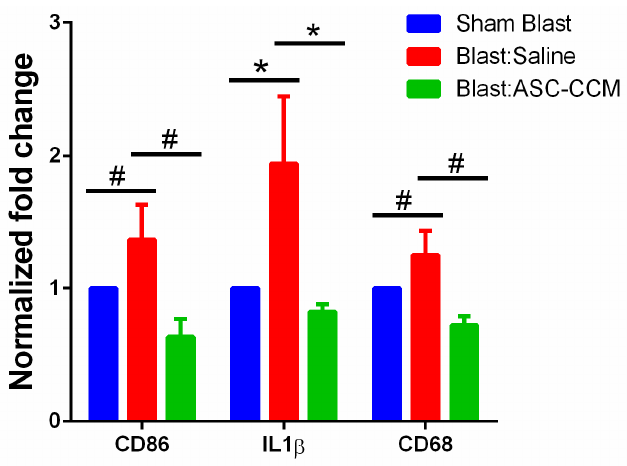
Figure 6. ASC-CCM reduces retinal inflammation in blast injury mice. ASC-CCM reduces retinal inflammation in blast injury mice. Assessment of gene expression by TaqMan qPCR and expressed as fold change normalized to internal control (18s rRNA) in the study groups. Data represent Mean ± SEM from n = 3–4 animals/group performed in duplicates repeated two additional times with similar data. #, p > 0.05; *, p < 0.05.